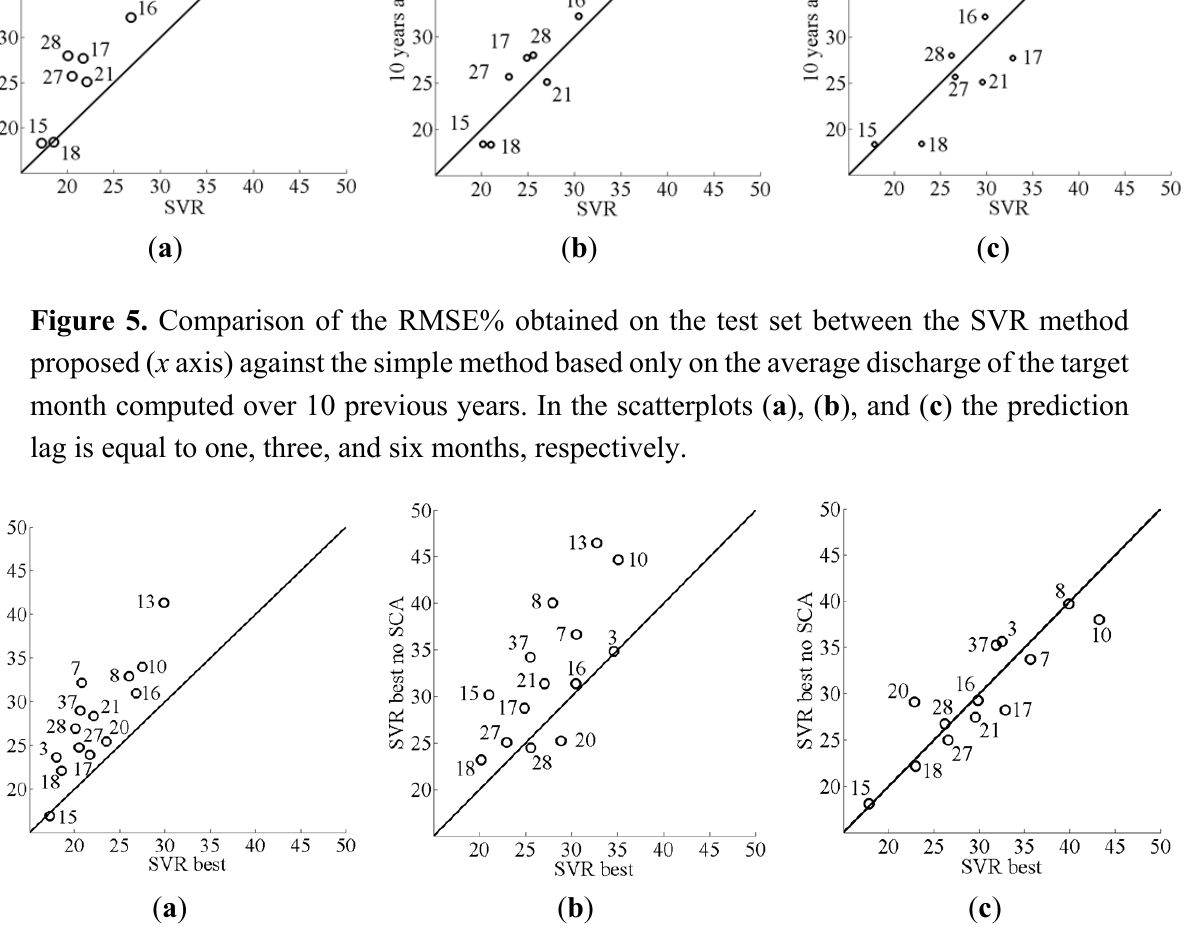
Figure 6. Comparison between the RMSE% obtained on the test set with (x axis) and without (y axis) SCA as SVR input feature. The scatterplots ( a ), ( b ), and ( c ) refer to the performances obtained by the SVR trained for the prediction with a lag equal to one, three, and six months,